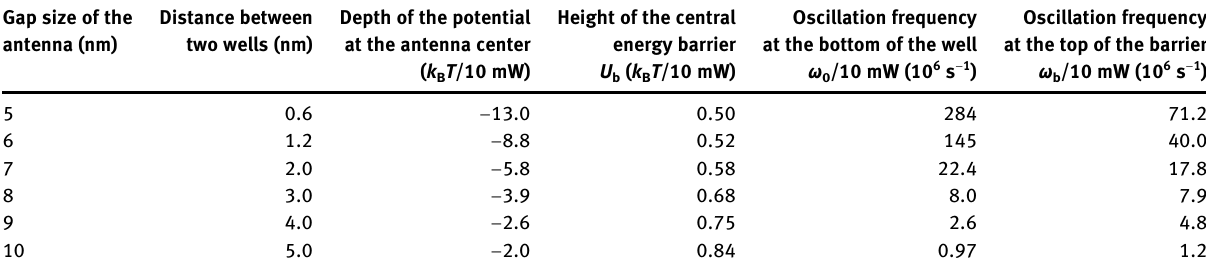
Table  : Calculated double-well potential properties with various gap sizes. Gap size of the Distance antenna (nm)